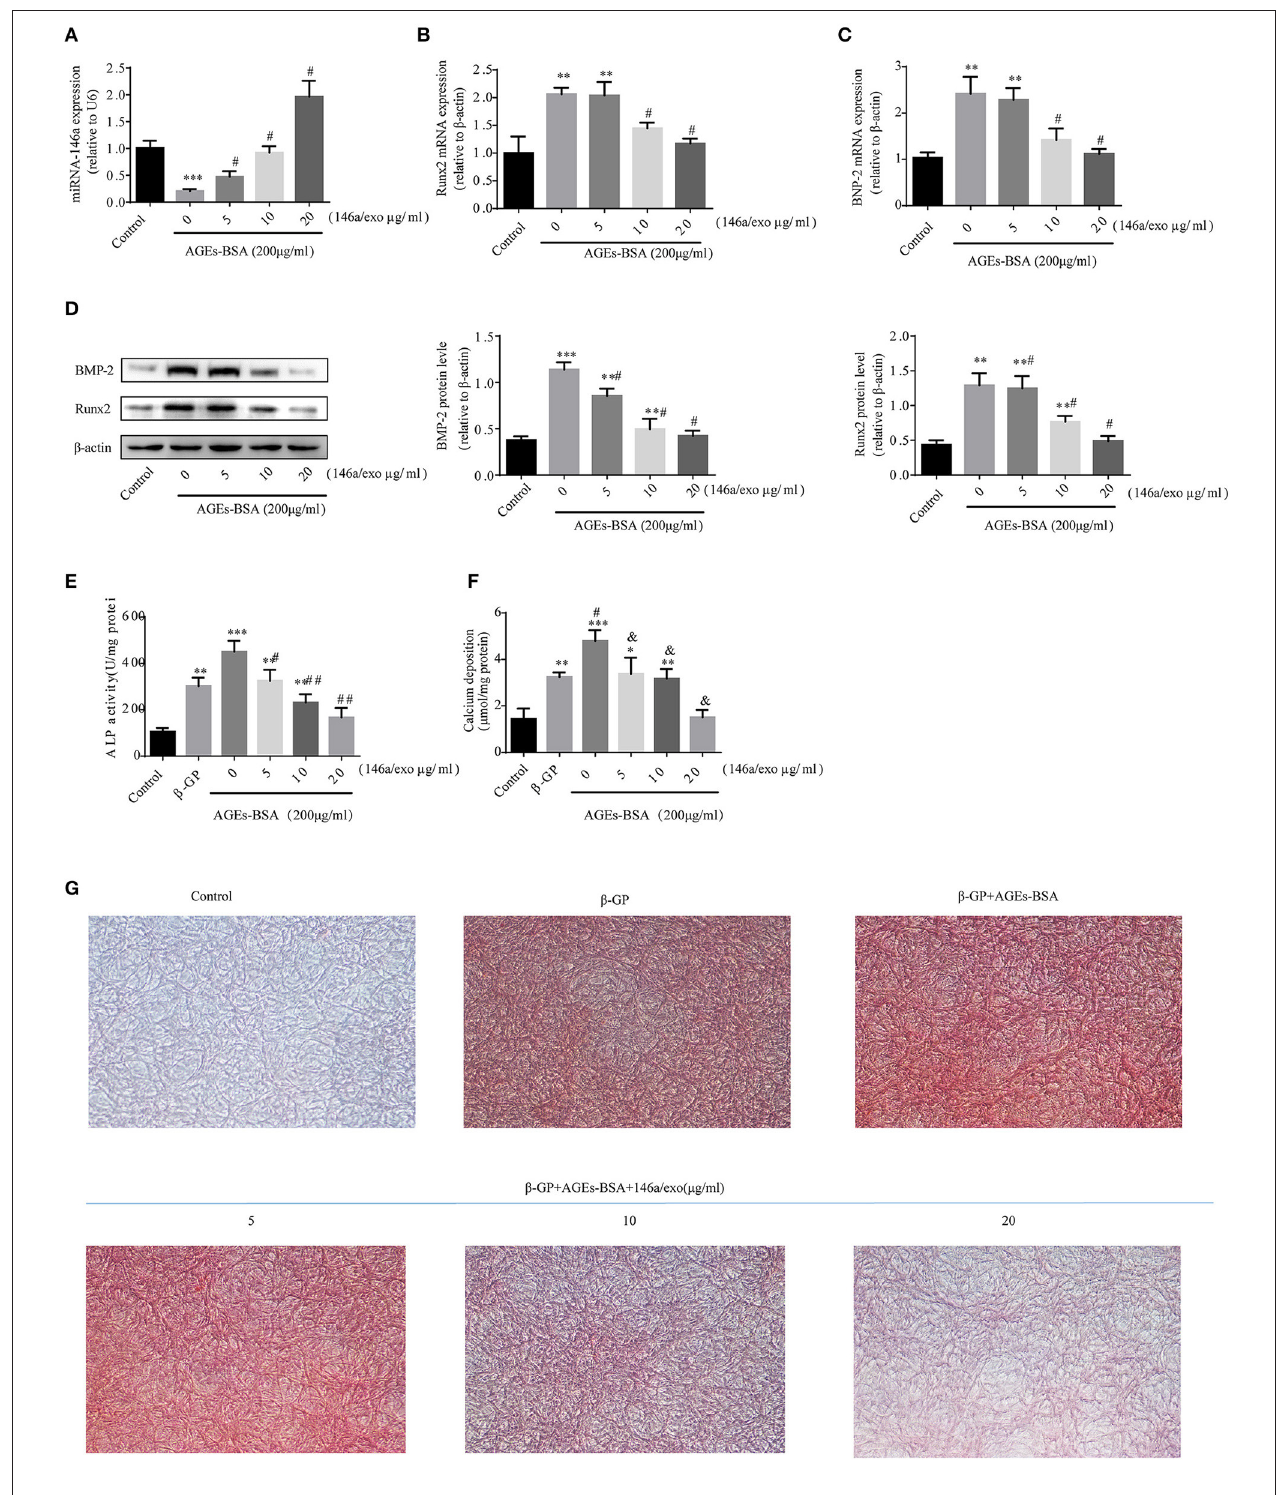
FIGURE 7 | 146a/exo inhibits AGEs-BSA-induced calcification of VSMC. (A) miR-146a expression determined by qPCR. * p < 0.05, ** p < 0.01, and *** p < 0.001 vs. the control group and; # p < 0.05 vs. AGEs-BSA group. Protein (B) and mRNA (C,D) levels of Runx2 and BMP-2 determined by Western blotting and qPCR. * p < 0.05, ** p < 0.01, and *** p < 0.001 vs. the control group and # p < 0.05 vs. AGEs-BSA group. (E) ALP activity. * p < 0.05 vs. the control group; # p < 0.05 vs. β -GP group; and & p < 0.05 vs. β -GP + AGEs-BSA group. (F) Intracellular calcium content. * p < 0.05 vs. the control group; # p < 0.05 vs. β -GP group; and & p < 0.05 vs . β -GP + AGEs-BSA group. (G) Calcium deposition by Alizarin Red S staining (magnification, 100 × ).